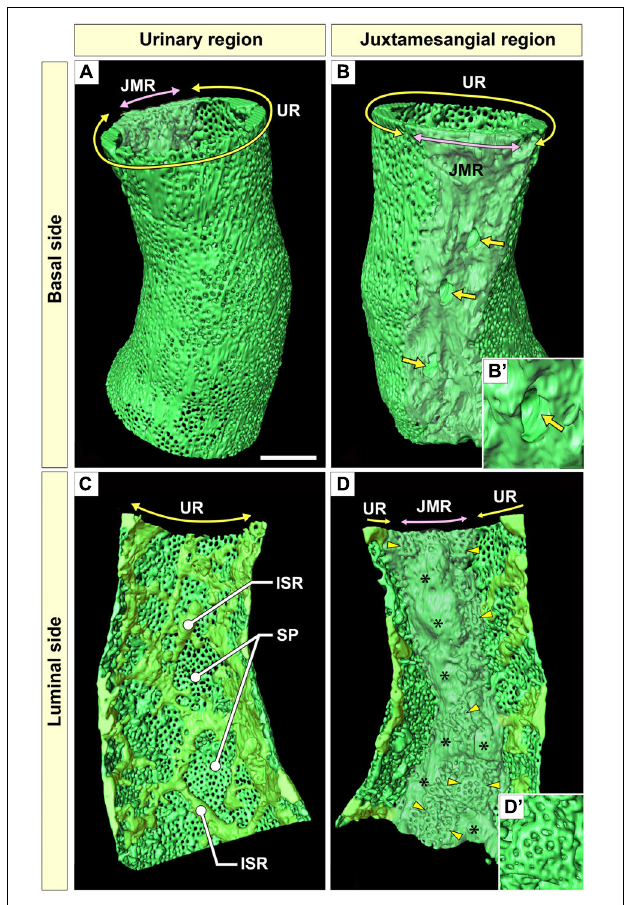
FIGURE 3 | Urinary region (UR) and juxtamesangial region (JMR) of a glomerular endothelial cell (GEnC). (A,B) Three-dimensional reconstruction of a single GEnC tube. The basal surfaces of the UR and JMR are predominantly shown in (A,B) , respectively. (A) In the UR, the basal surface is smooth in total despite the high fenestration. (B) In the JMR, the basal surface is uneven with less fenestration. The indentations for mesangial cell processes were frequently recognized (arrows). (B (cid:48) ) High magnification of an indentation created by a large non-adhesive mesangial cell process. The GEnC tube in (A,B) is longitudinally divided into two halves, and the luminal surfaces of the UR (C) and JMR (D) are shown. (C) In the UR, the sieve plates are among the fine intersieve ridges (yellowish-green). (D) In the JMR, the thick juxtamesangial cytoplasmic ridge could be found (asterisks, whitish-green). The reticular porous structures are frequently recognized on and beside the thick juxtamesangial ridge (arrowheads). (D (cid:48) ) High magnification of the reticular porous structure. ISR, intersieve ridge; SP, sieve plate. Scale bar, 5 µ m. The reconstructed images of GEnC (A–D) are also shown in Supplementary Movies 1–3